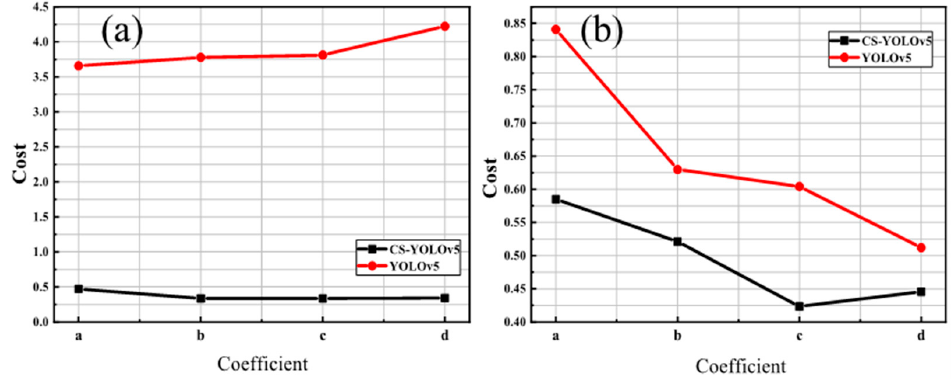
Figure 5. ( a ) Cost ( × 10 − 3 ) with varying risk coefficients on NEU ( b ) Cost ( × 10 − 3 ) with varying risk coefficients on Paint.